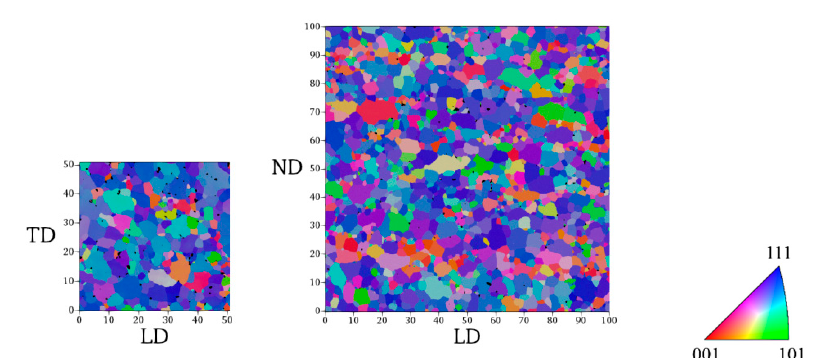
Figure 1. EBSD inverse pole figure (IPF) maps (in the ND direction) along two perpendicular planes: LD–TD on the left, and LD–ND on the right. Carbides are represented in black. Dimensions are given in micrometres.